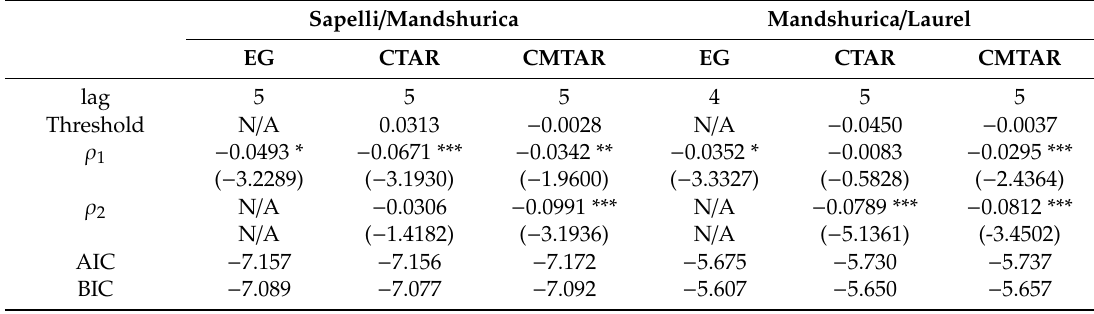
Table 6. Results of the Engle–Granger and threshold co-integration model for the second